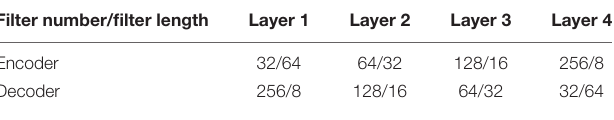
TABLE 1 | The number and length of filters in the DCAE model. Filter number/filter length